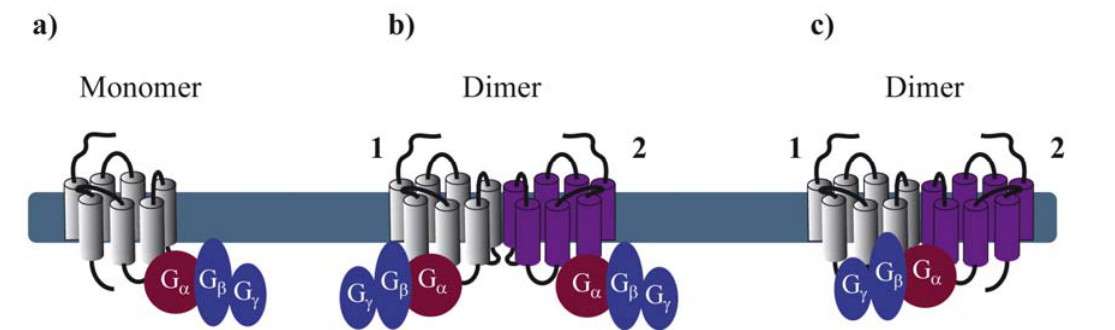
Figure 1. Stoichiometry of G protein coupling to GPCR dimers. (a) The minimal functional unit is constituted of one monomeric receptor and one heterotrimeric G protein; (b) Two G proteins binding, each, one protomer within a dimer; (c) Asymmetric G protein coupling to a receptor dimer: only one G protein binds one protomer of the